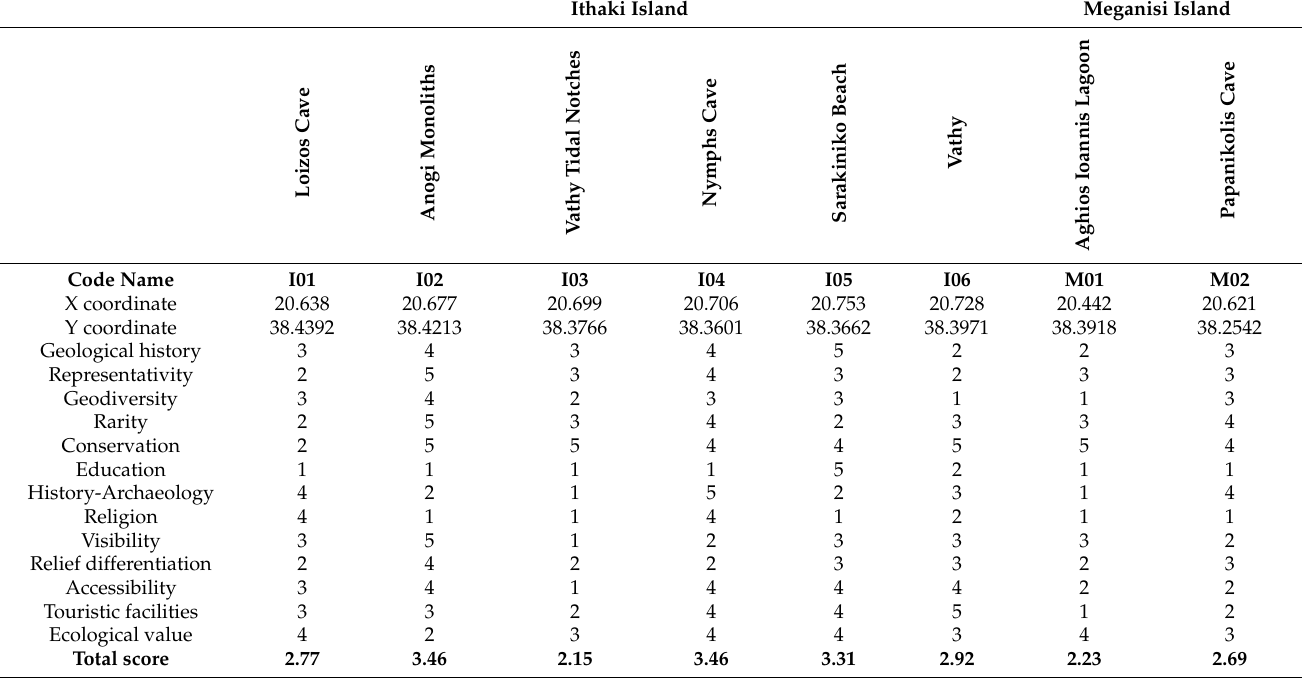
Table 4. Ithaki and Meganisi islands geosites assessment, following the evaluation criteria of Table 1. Ithaki